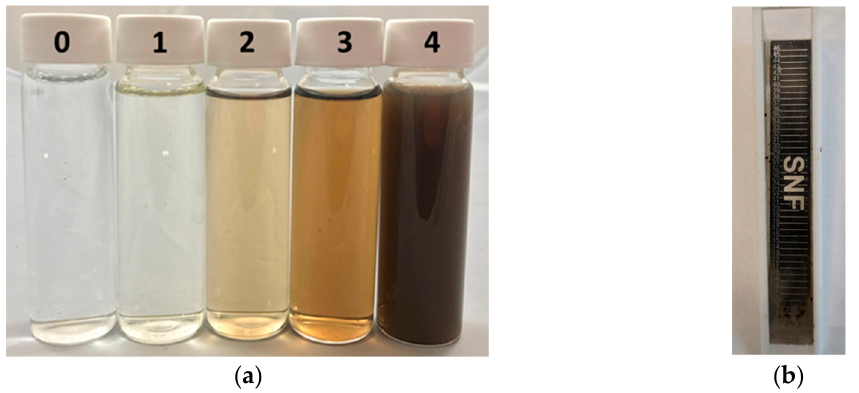
made 5-scale category (Figure 4a): 0—clear and colorless; 1—pale yellow; 2—yellow or light brown; 3—brown; and 4—black. The clarity of the release water was measured by a clarity wedge with 0–46 scales donated by SNF Canada (Figure 4b).